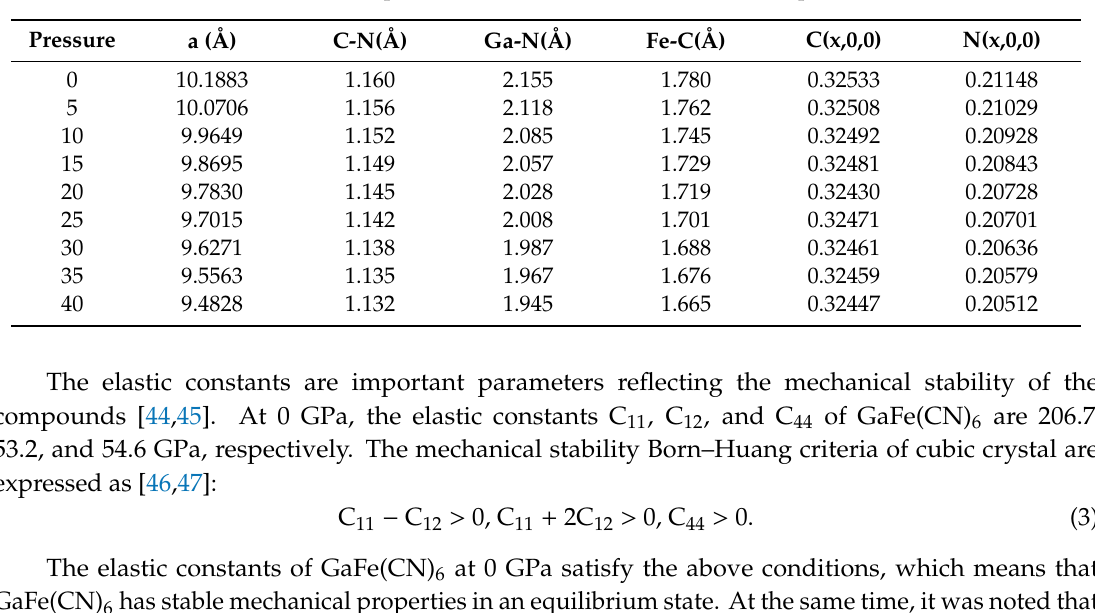
Table 2. Structural parameters of GaFe(CN) 6 under di ff erent